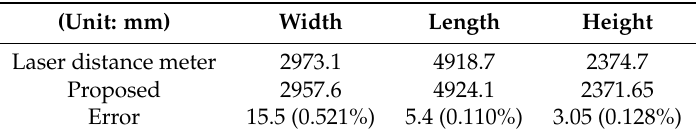
Table 2. The results of the room